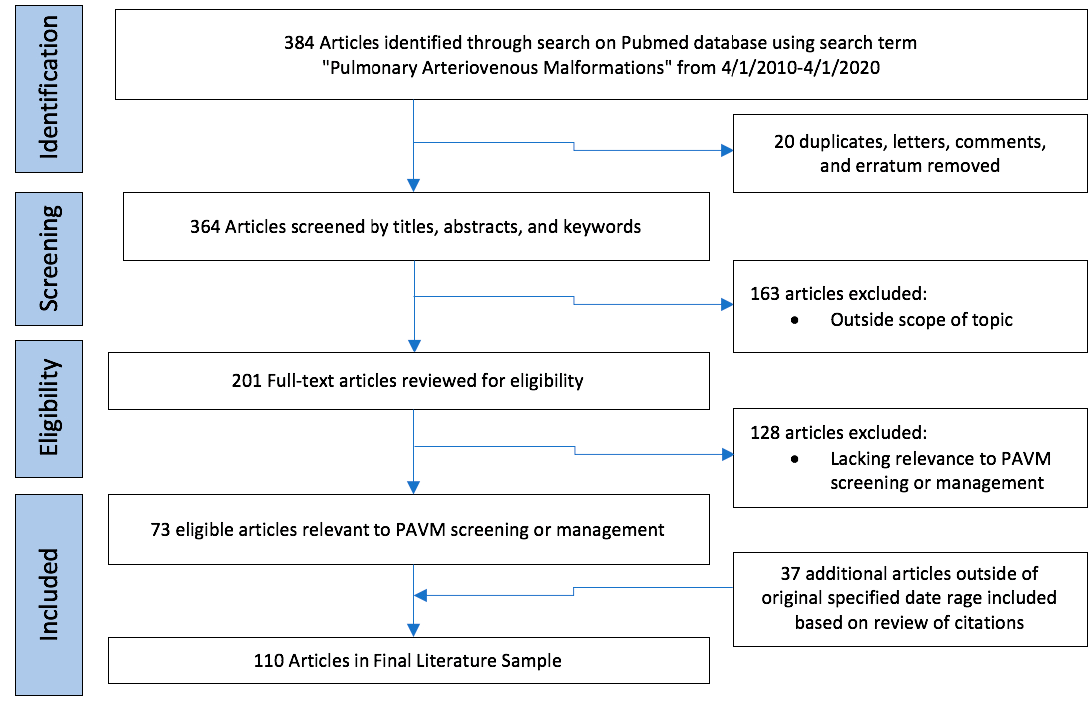
Figure 1. Flowchart for literature selection for narrative review.